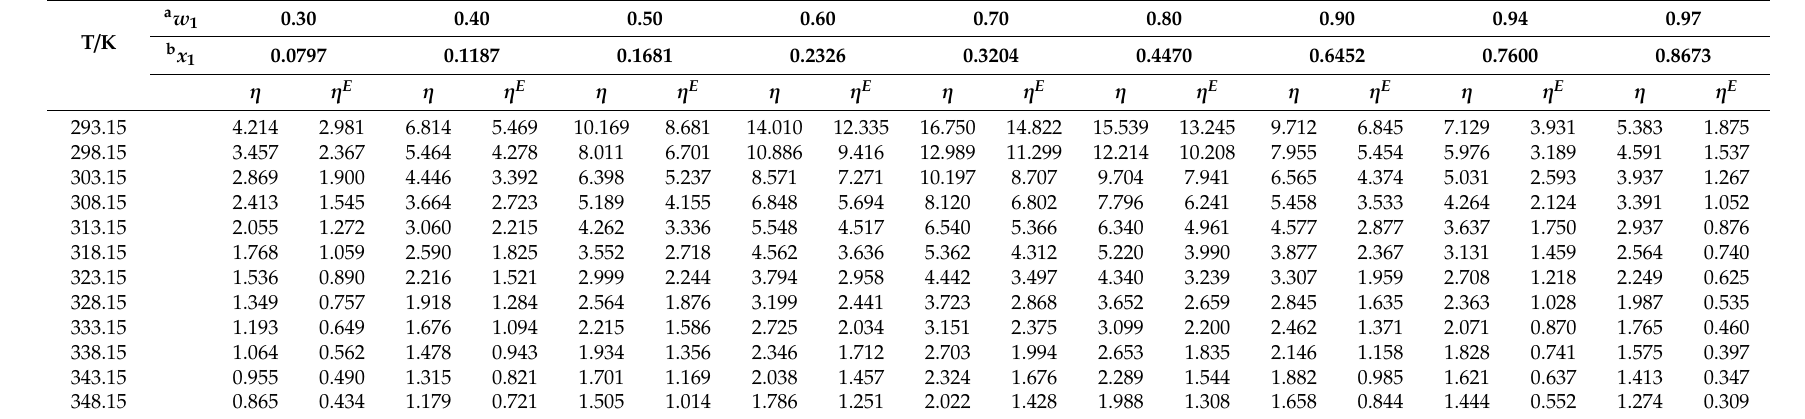
Table A6. Measured viscosity ( η / mPa · s) and deduced viscosity deviation ( η E / mPa · s) of DMEA (1) + H 2 O (2)